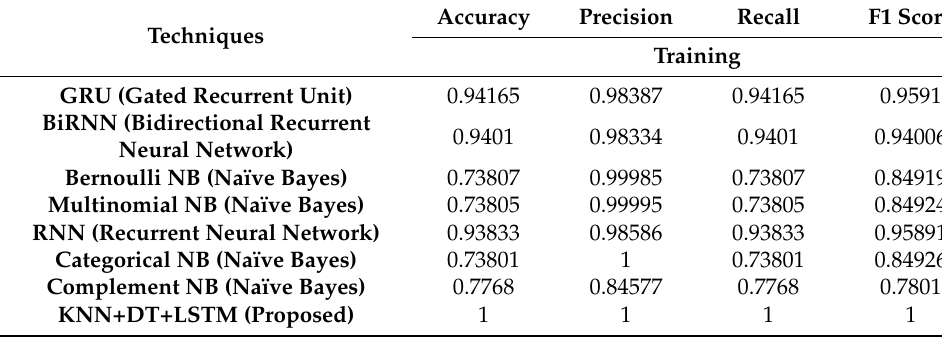
Table 2. Performance Metrics of Different ML/DL Models (Training).